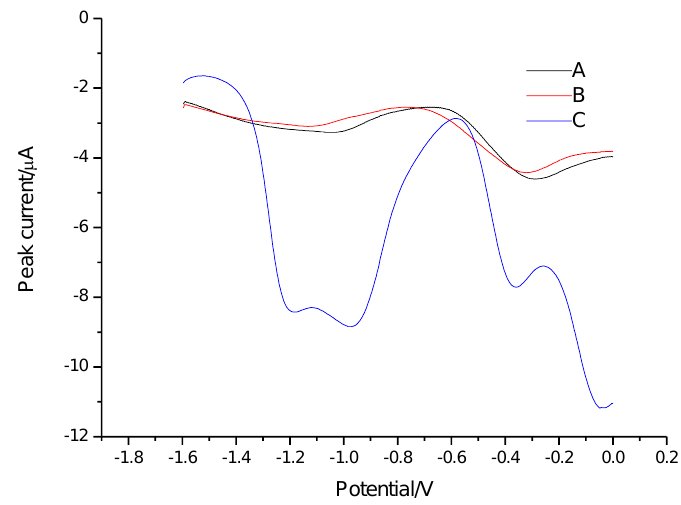
Figure 1. The square-wave anodic stripping voltammetry (SW-ASV) on gold disk electrode (GDE) at different condition: (A) [C 8 mim][PF 6 ]; (B) oxine in [C 8 mim][PF 6 ]; (C) IL-based liquid phase microextraction (LPME) of 0.4 ng L − 1 Al(III) in presence of 0.67 mmol L − 1 oxine.